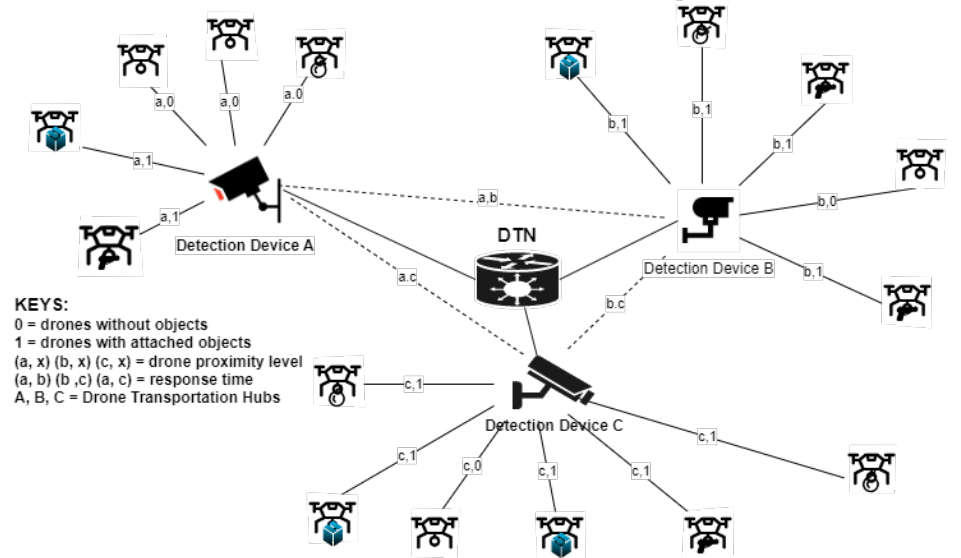
Figure 7. Assisted learning scheme for invasive encroachment neutralization in a DTN highlighting the various hubs of surveillance